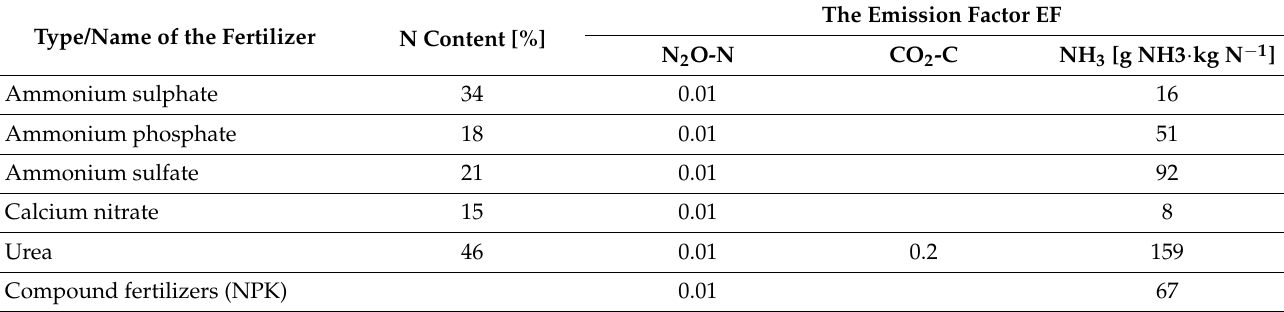
Table 3. N content and emissions factor for NH3 for selected inorganic fertilisers 1